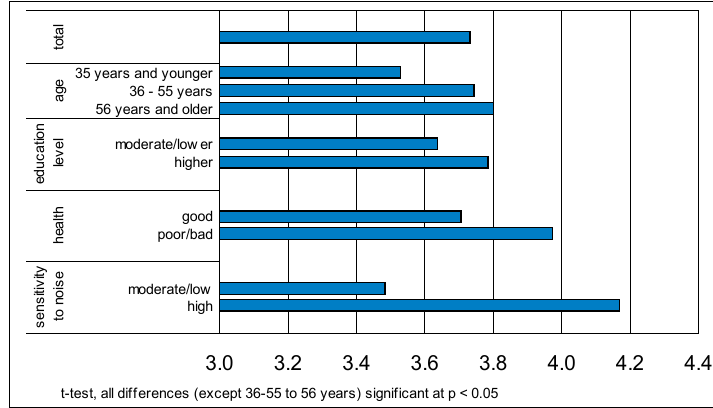
Figure 1. Need for quiet for different individual characteristics (scale 1, …,